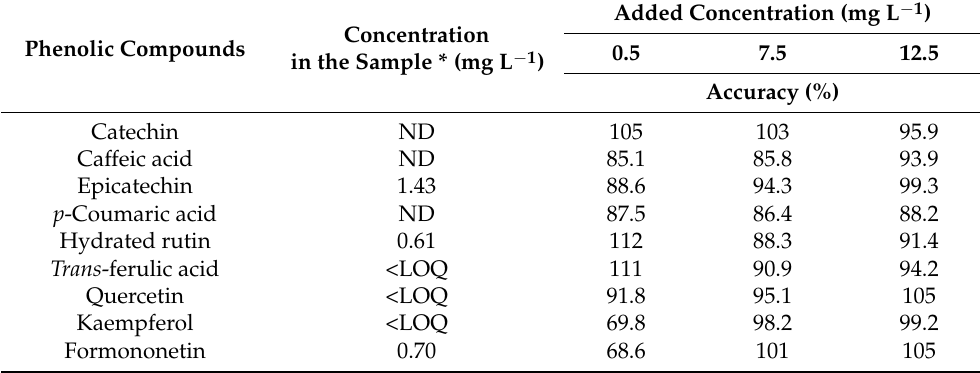
Table 3. Accuracy (recovery tests) of the method for determination of phenolic compounds in Brazilian craft beers.